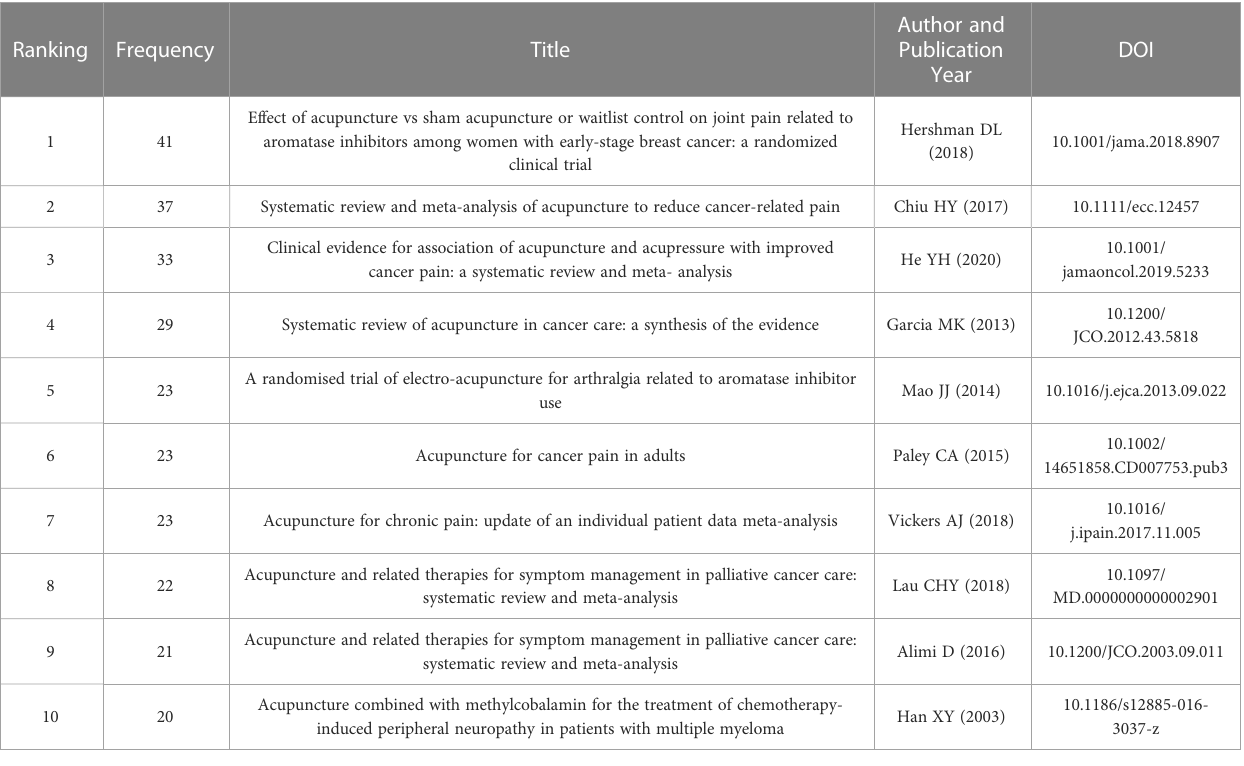
TABLE 8 Top 10 most frequently cited references related to studies on acupuncture for cancer